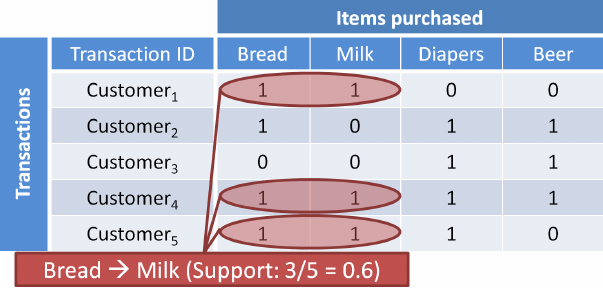
Figure 2. Simplistic traditional representation of market basket data in the form of transactions. The Bread → Milk rule has a support of 0.6, meaning it appears in 60% of the